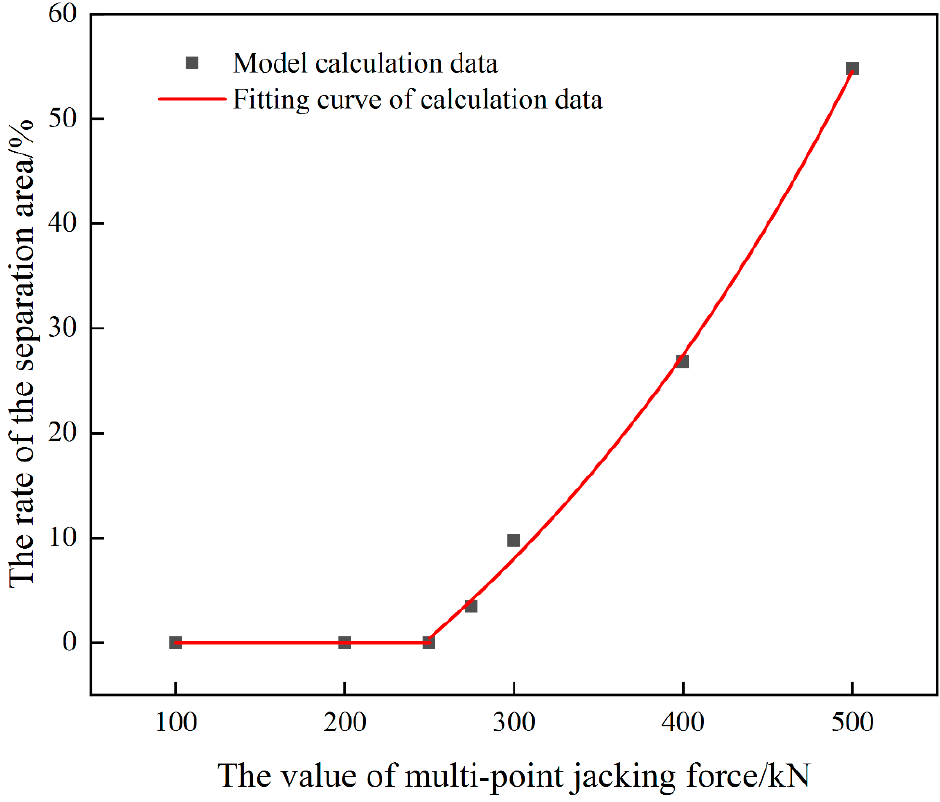
Figure 14. The ratio of the separated area to the total interface area when different jacking forces are applied under the condition of multi-point jacking.